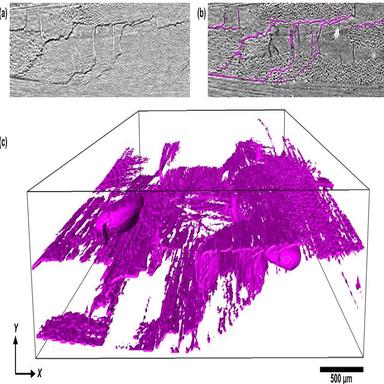
(a) Slice of the image of the A-RT-1 sample as seen in c with the macrocracks highlighted in purple using the residual field; (b) residual image of the same slice; (c) 3D representation of the analysed crack segmented from the residual field of global DVC on A-RT-1 (step 1 – step 4 in Table S2); shown through the entire width of the specimen.